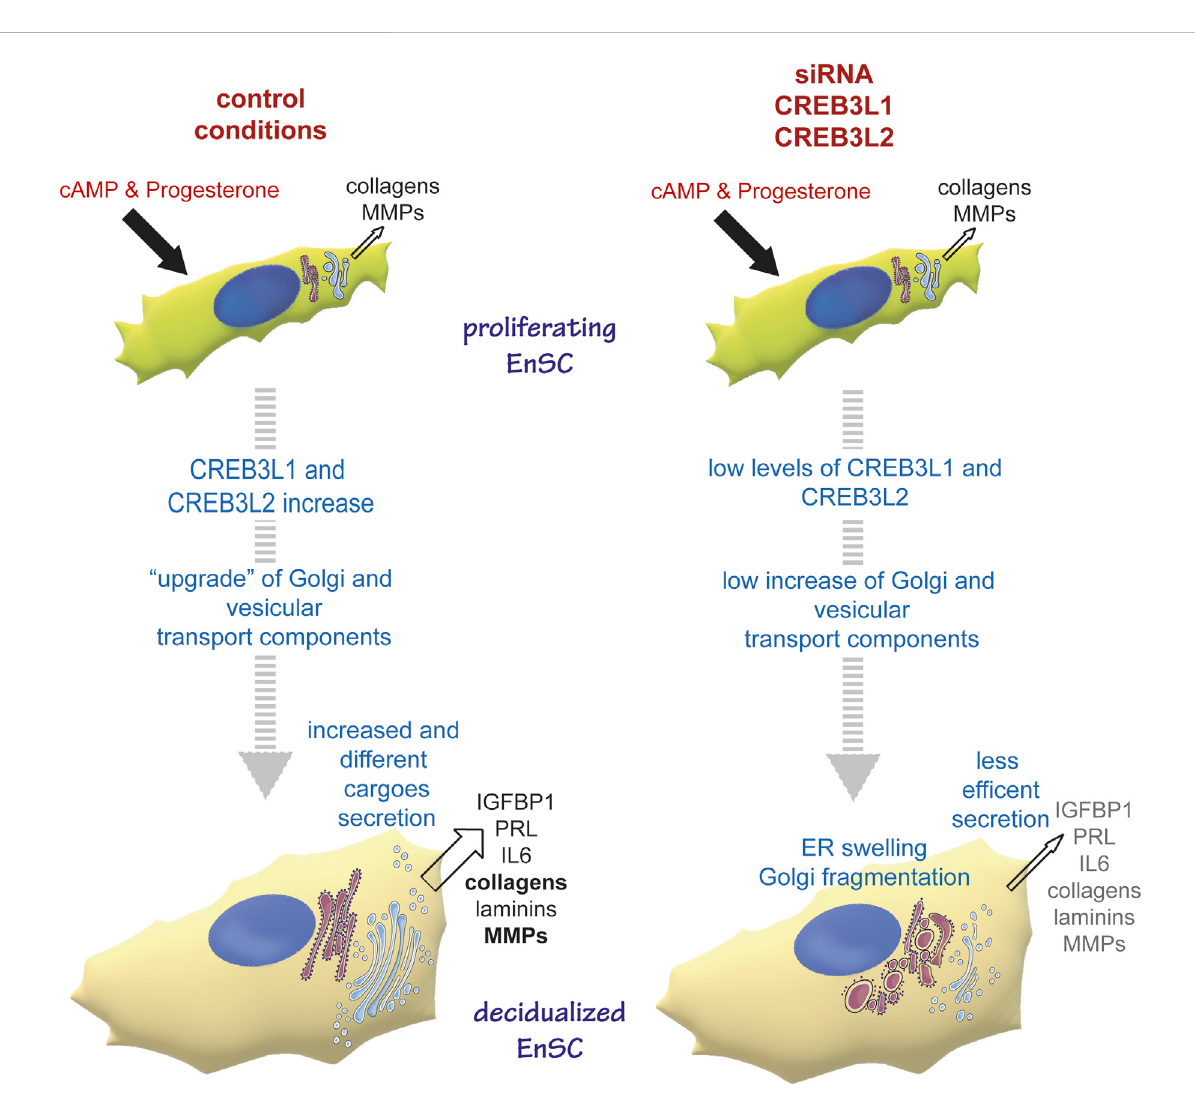
FIGURE 8 CREB3L1 and2 mediatethereshaping oftheearlysecretory pathway during decidualization. Under proliferating conditions, EnSC produceand secrete some collagens and MMPs. The decidualising stimulus induces upregulation and activation of CREB3L1 and CREB3L2, which have consequences on cell morphology, with a reshaping of the early secretory pathway. Thus Golgi and ER to Golgi vesicular transport components are up-regulated,whichensuresmoreef fi cientsecretionofnewanddifferentcargoes.InconditionsofCREB3L1and/or2KD,thecellsarenotable to adjust their secretory machinery to the new cargo load and production. Hence the ER swells, Golgi morphology is profoundly affected (with no enlargement and cisternae fragmentation) and secretion in general is